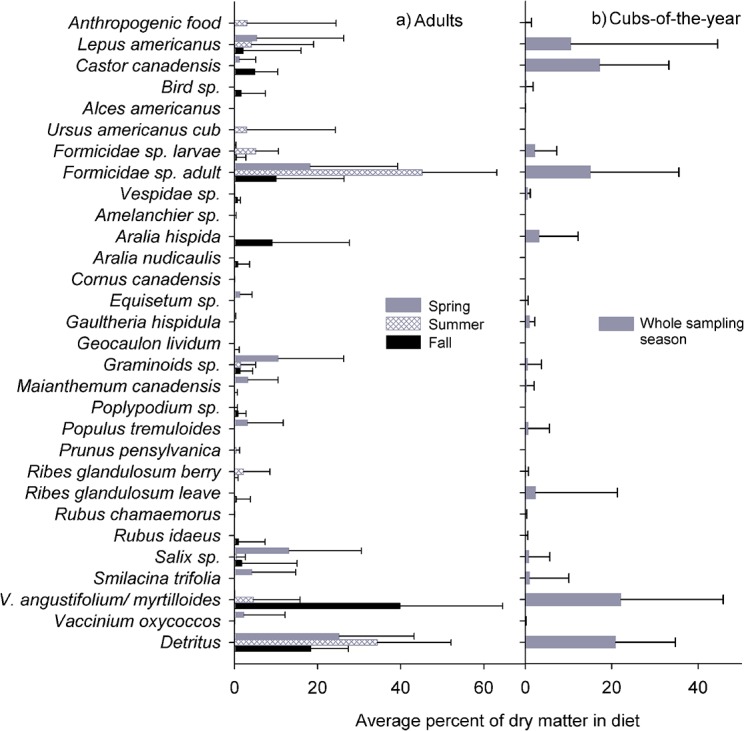
Corrected proportion of dry matter ingested of food items found in feces.a) Adults feces (n = 120 feces/71 sites) for spring (n = 47 feces/24 sites; May 15th–June 14th), summer (n = 32 feces/20 sites; June 15th–July 31st) and fall (n = 41 feces/27 sites August 1st–September 14th). b) Cub-of-the-year feces (n = 30 feces/13 sites) for the whole sampling season (May 15th–September 14th). Error bars represent the standard deviation.